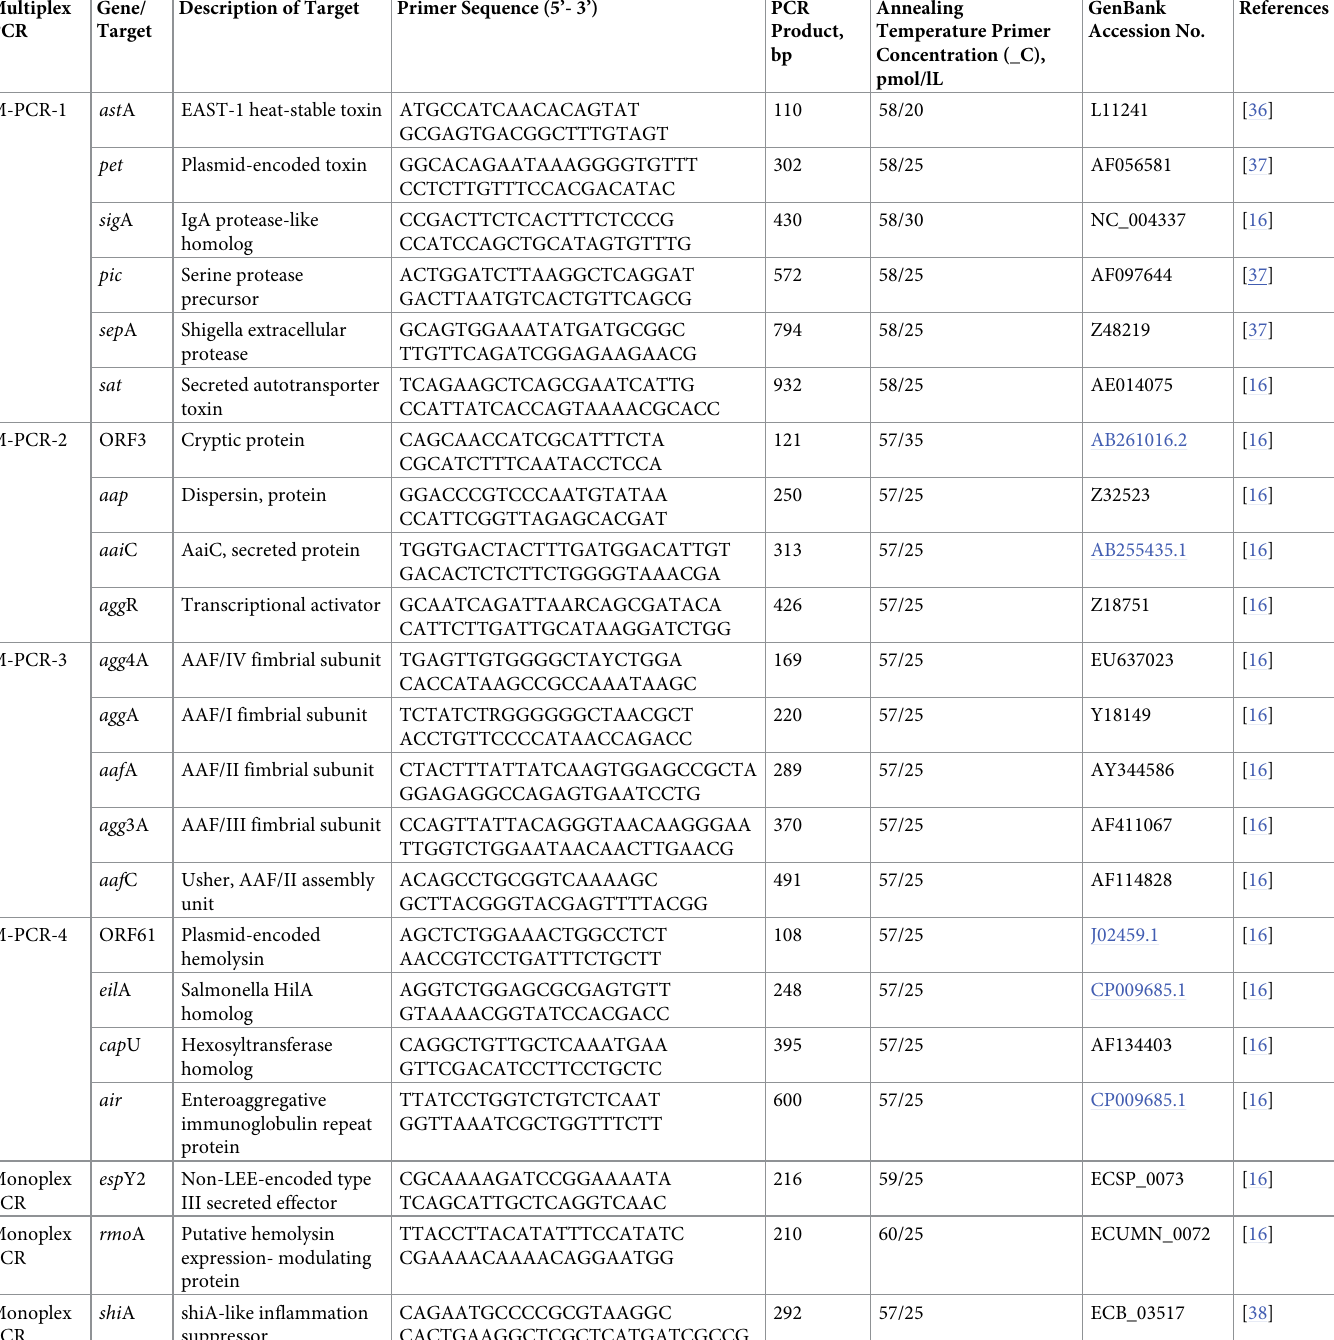
Table 2. Primers used for the 4 multiplex polymerase chain reactions (M-PCRs) and 3 monoplex PCRs, target gene description, base-pair size, annealing tempera- ture, and primers